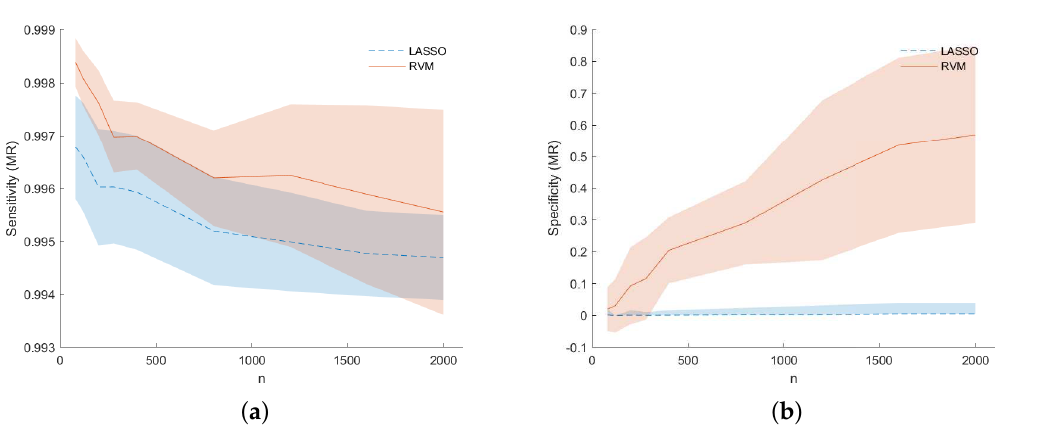
Figure 7. dataset (f): Sensitivity ( a ) and Specificity ( b ) as regard Model Recovery (MR) ability for LASSO (dashed) and RVM (solid). Shaded areas for standard deviation across the MC